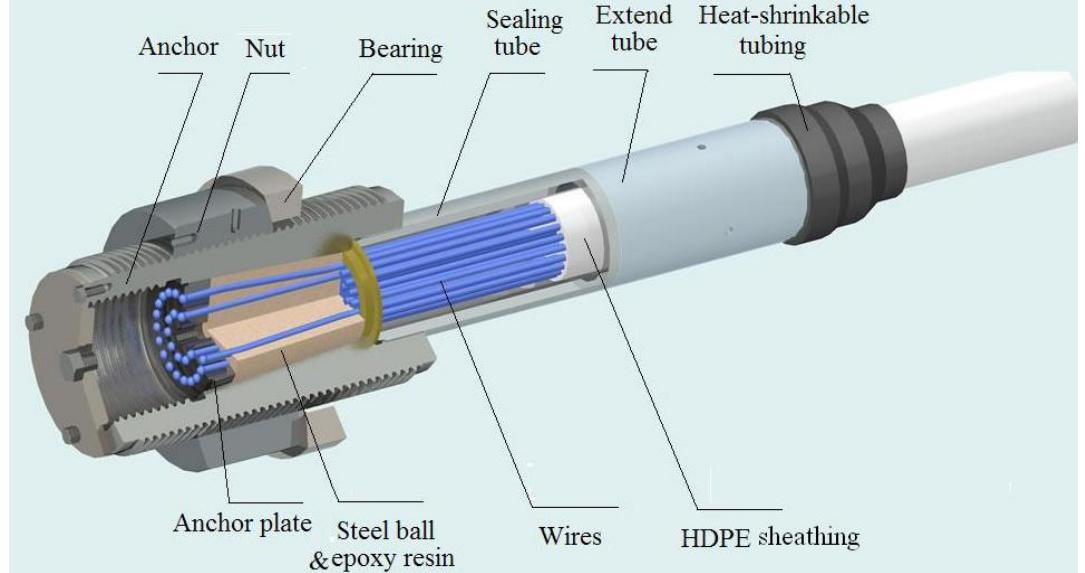
Figure 2. Schematic diagram of a parallel wire